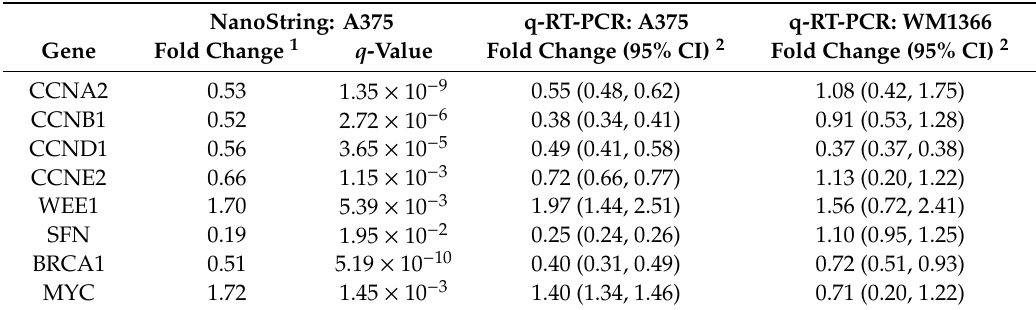
Table 4. Gene expression changes found by NanoString PanCancer array and q-RT-PCR. NanoString: A375 q-RT-PCR: A375 q-RT-PCR: WM1366